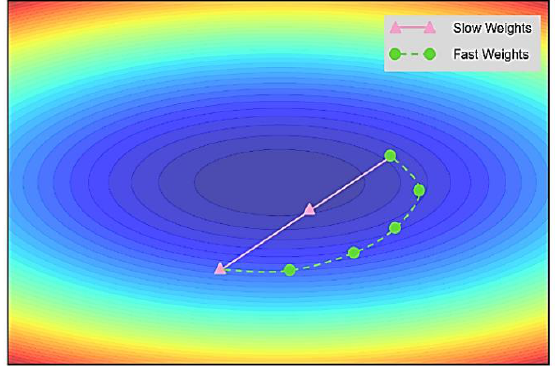
Figure 6. Principle of LA optimization.